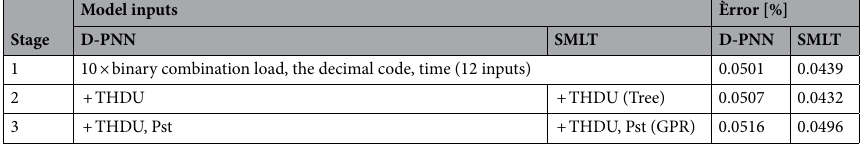
Table 4. Power Factor PF 3-step model estimations.